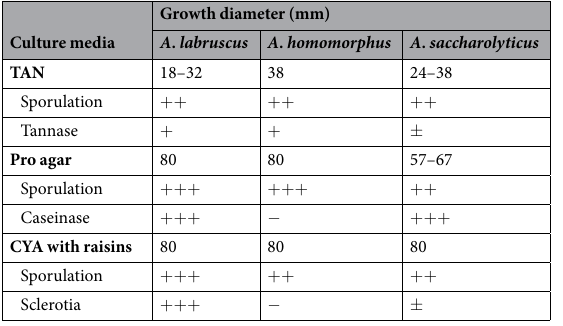
Table 5. Growth, sporulation and production of extracellular enzymes of Aspergillus labruscus , A . homomorphus and A . saccharolyticus . − None, ± Poor, + Some, ++ Good, +++ Very